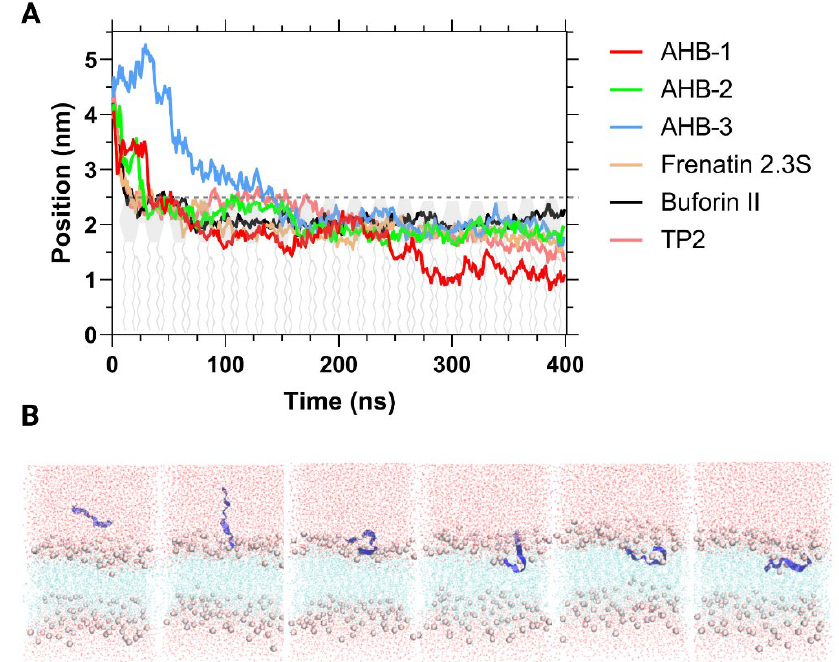
Figure 8. ( A ) Average distance between peptide and membrane’s COM with a flat-bottom restraining potential during 400 ns of simulation. The dotted grey line represents the water-membrane interface. ( B ) Snapshots of AHB-1 peptide trajectory at 25, 70, 120, 200, 250, and 320 ns along the span of the DPPC membrane.